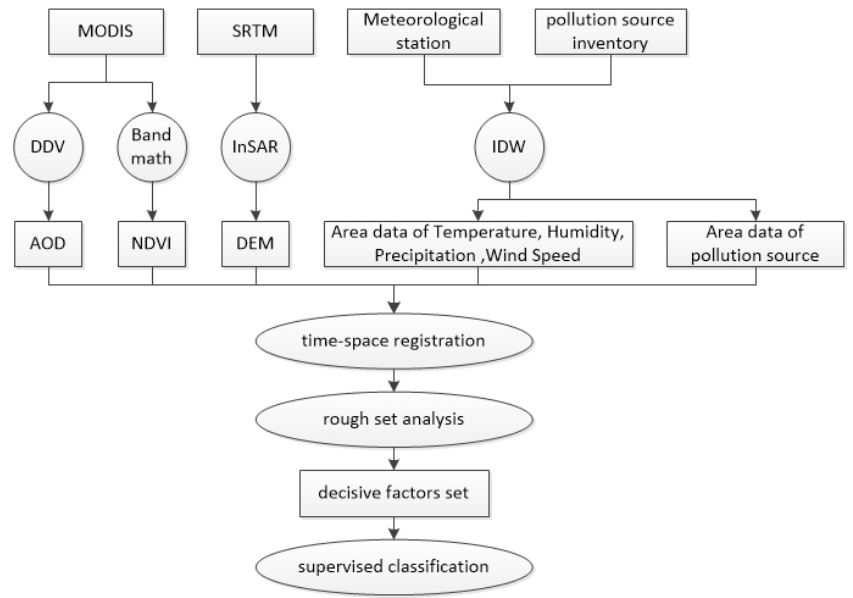
Figure 2 schematic diagram of proposed